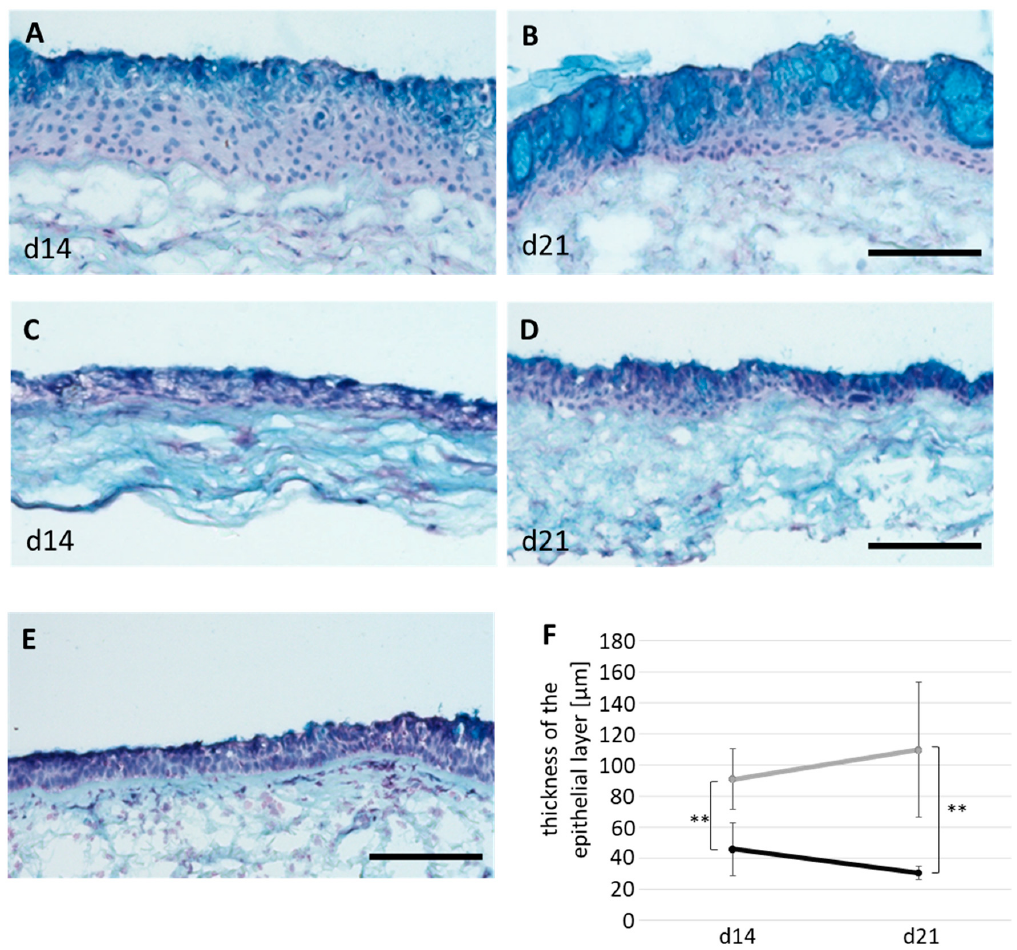
Figure 2. Histological characterization of 3D airway tissue models. Models were cultivated for 14 and 21 days, respectively, at air-liquid-interface (ALI) with either AECG or PneumaCult ALI (PC ALI) medium. ( A , B ) Alcian blue staining of cross sections of 3D models cultivated with AECG for ( A ) 14 and ( B ) 21 days (n = 10 each from four donors). ( C , D ) Alcian blue staining of cross sections of 3D models cultivated with PC ALI for ( C ) 14 and ( D ) 21 days (n = 6 each from four donors). ( E ) Alcian blue staining of native bronchus (control). ( F ) Determination of the epithelial layer thickness (AECG (light grey), n = 9; PC ALI (dark grey), n = 6, both from four donors). Scale bar: 200 µ m. Shown are the mean average with standard deviation. ** p <